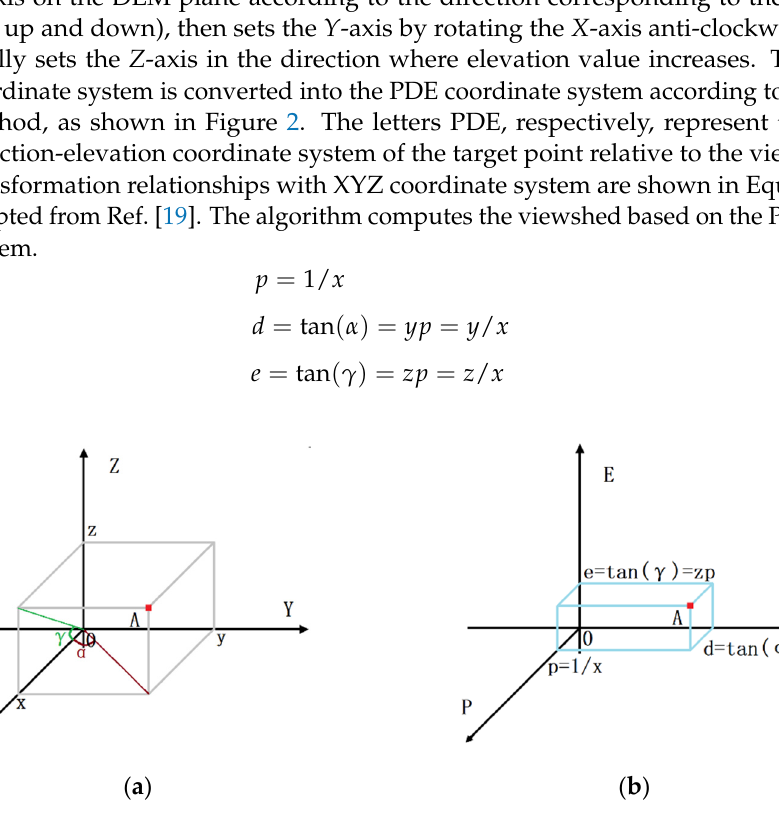
Figure 2. Point A in different coordinate systems: ( a ) The XYZ coordinate system; ( b ) The PDE coordinate system.